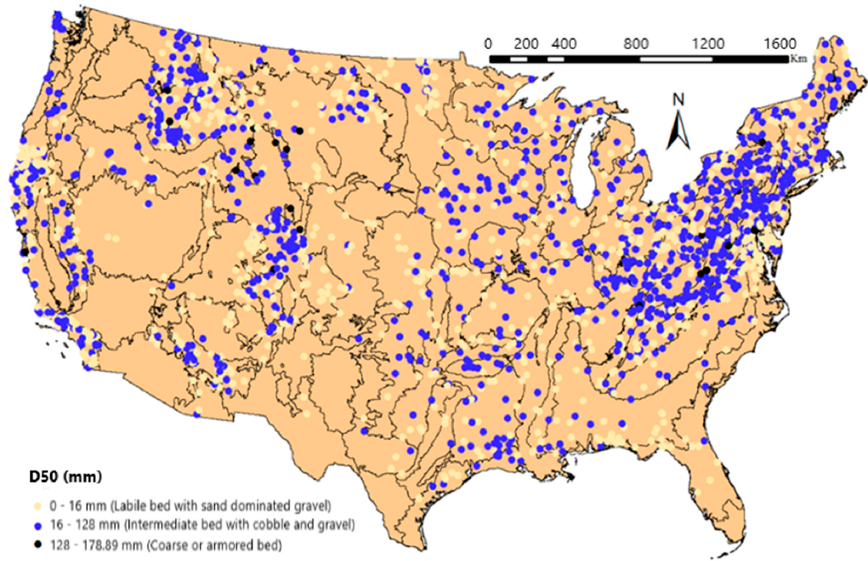
Figure 5. Streambed D50 values over Level III Ecoregions based on the channel susceptibility scheme.